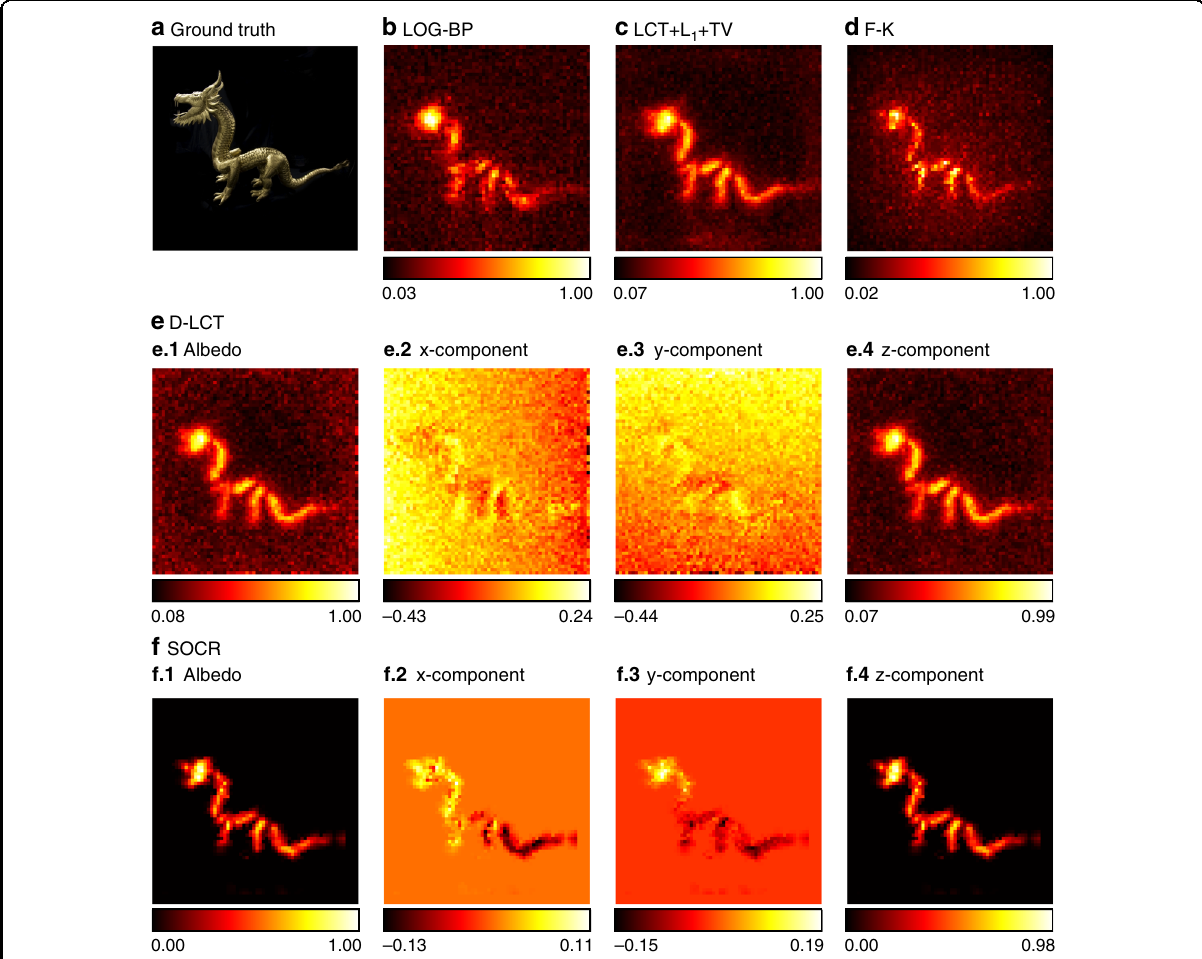
Fig. 9 Reconstruction results of the dragon (confocal, 60 min). The ground truth is shown in a . Reconstructions are shown in b – f . The reconstruction results of the BP, LCT + L 1 + TV, F-K, and D-LCT methods are noisy due to the specularity of the dragon and heavy noise in measured data. Our framework provides a reconstruction with little noise outside the